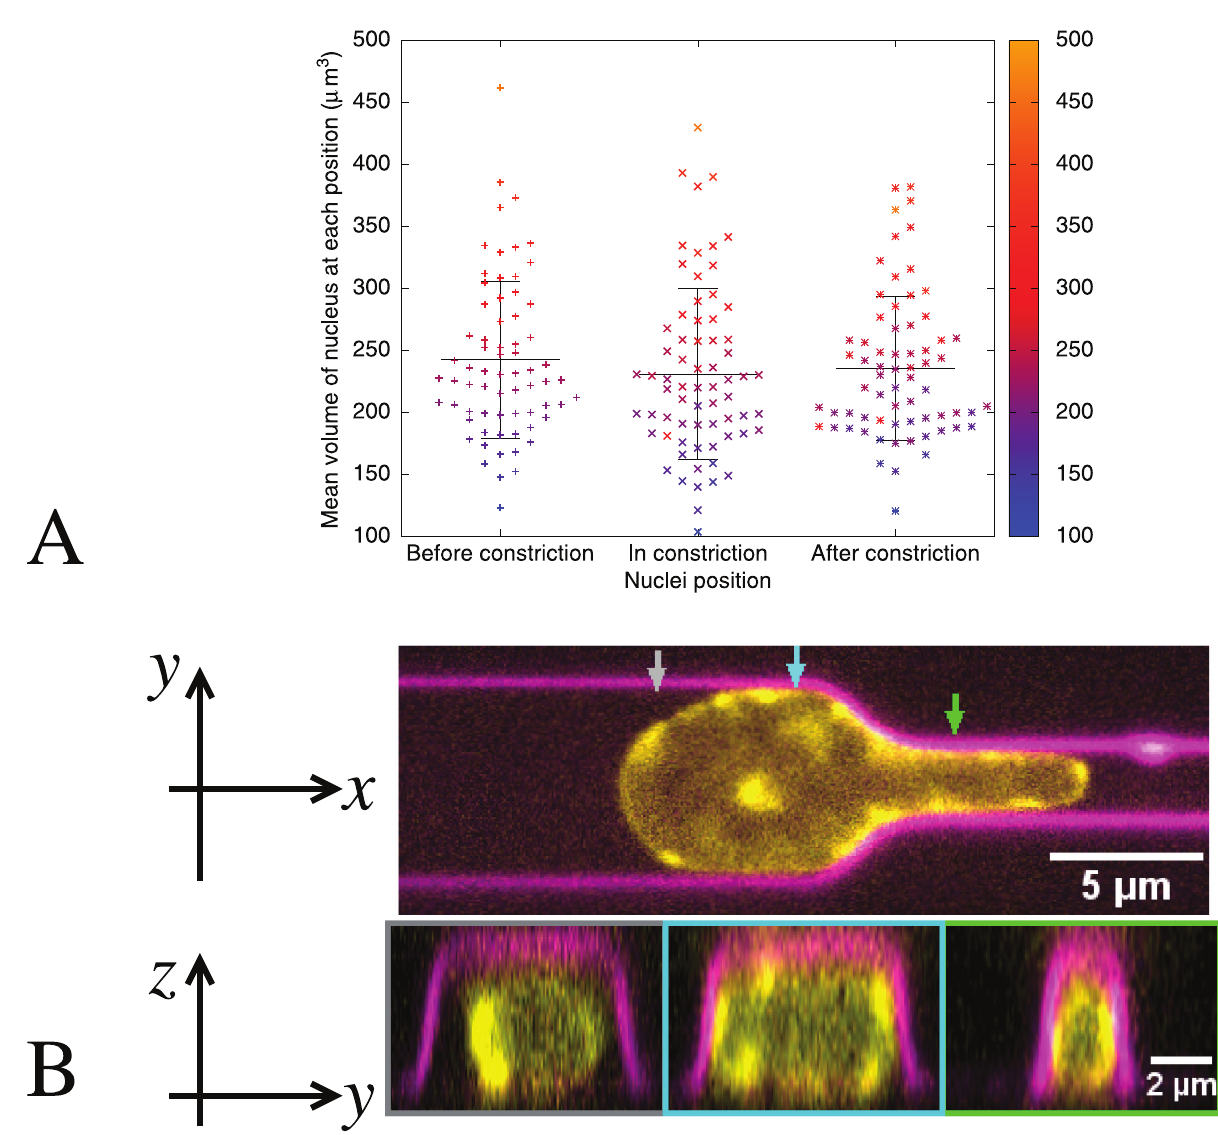
Fig 2. A. The mean volume of each nucleus in μ m 3 before the nucleus enters the constriction, while any part of the nucleus is between the constriction entry and exit, and after the nucleus has exited the constriction. The mean volume of each nucleus is calculated by the mean volume of that nucleus at all available time frames during which the nucleus is before/in/after the constriction. This is a mean of a few time frames since typically there are 10–20 time frames in total for each cell. Each point on the graph represents an individual nucleus with an identifying colour. The colour scale blue to red to orange is the volume of the nucleus before the constriction from small to large. Nuclei in the later positions keep their colour as defined by their volume before the constriction. The fact that the colours of the points stay mostly in the same order shows that the volume of a particular nucleus is roughly constant. The black horizontal lines show the mean volume of nuclei at that position and the vertical black lines indicate the standard deviations. Clearly there is no significant difference in mean nuclear volume as a nucleus travels through the constriction. B. Side view of a nucleus in a channel. Spinning disc confocal image of a dendritic cell with the DNA (in yellow) stained with Hoechst, migrating through a channel with a 2 μ m wide and 20 μ m long constriction. Channels are coated with mCherry-PEG (magenta). Top image: top view of the channel. Bottom image: orthogonal/side view of the channel. Arrows (grey, cyan and green) in upper image indicate the slicing regions depicted in the bottom image surrounded by grey, cyan and green rectangles.